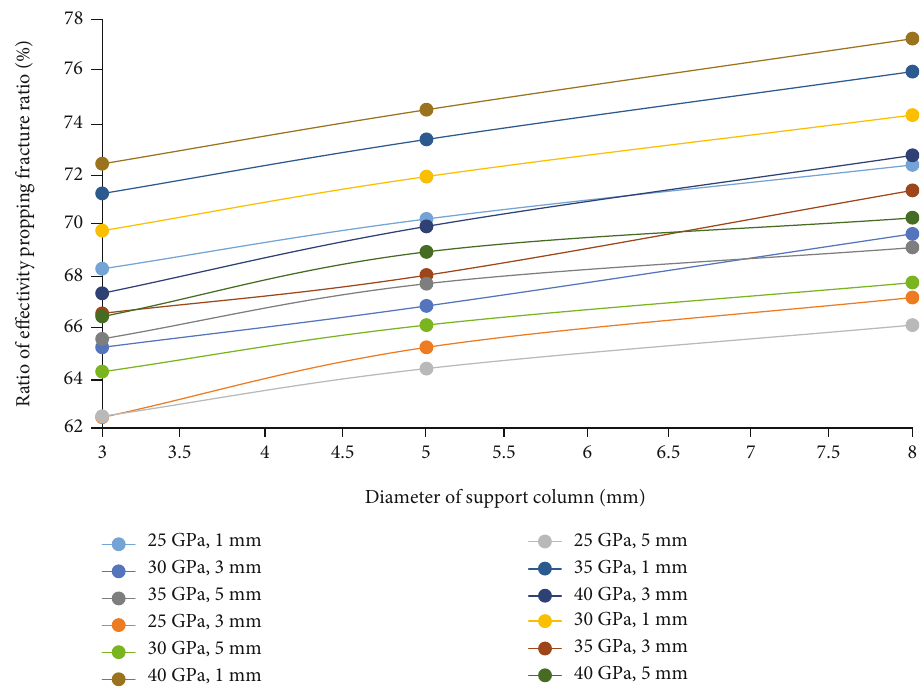
Figure 51: The e ff ect of proppant height on the ratio of e ff ective propped fractures under 60 MPa in situ stress and di ff erent elastic